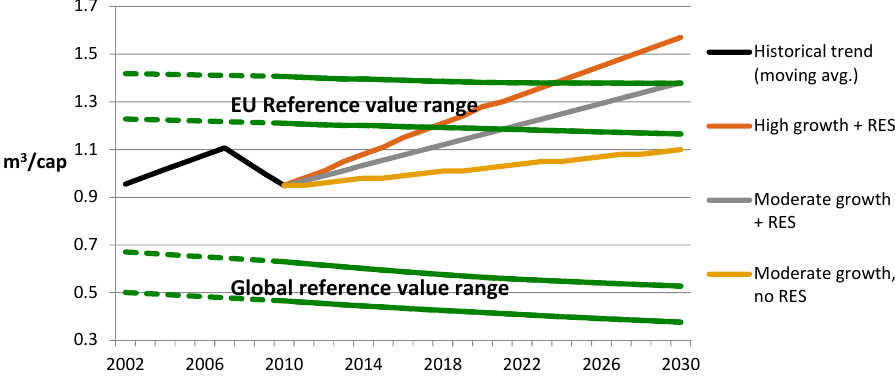
Figure 4. EU consumption levels of primary timber compared to global and EU reference value ranges for sustainable forest supply capacities, 2002–2030. Note: The EU and global reference value ranges are visualized in an indicative way back to 2002 for comparative purposes. This is based simply on an extension of trends. Future EU consumption projections are based on the trends given in literature sources [18,35], noting that primary timber demand may be overestimated due to simplified assumptions. Past EU consumption trends are based on O’Brien and Bringezu